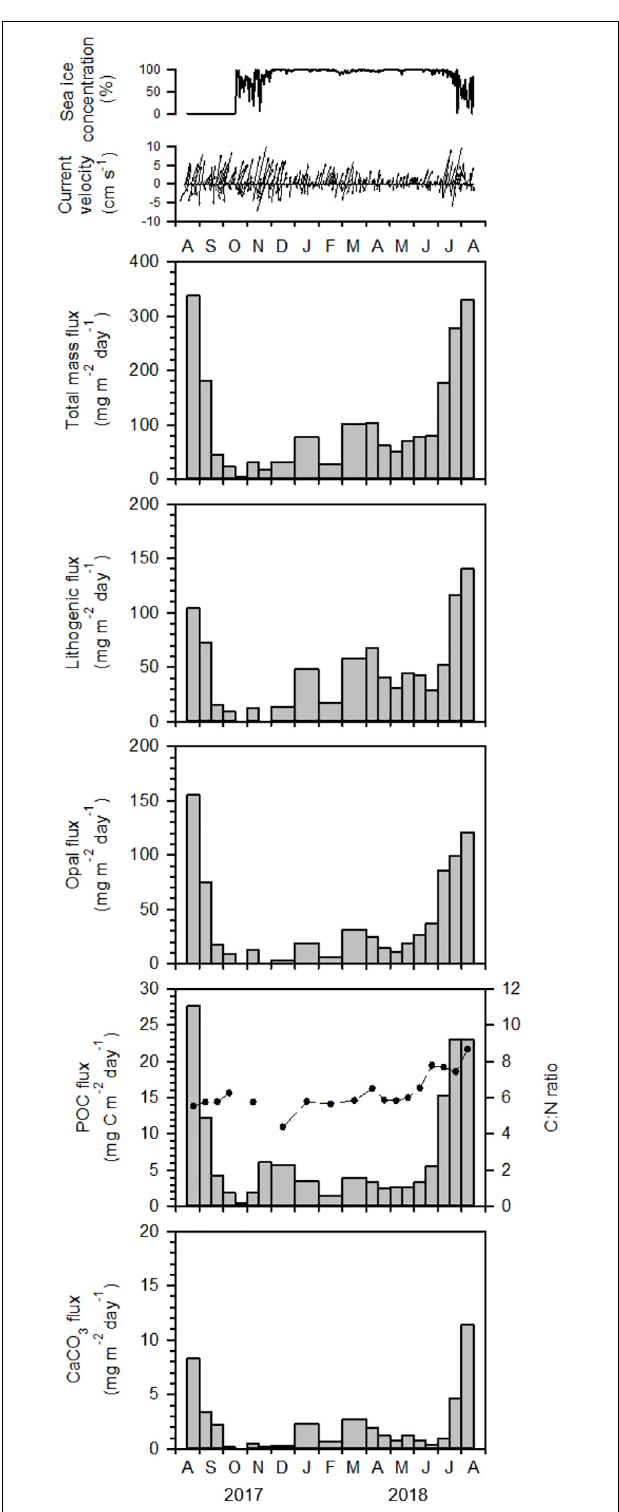
FIGURE 3 | Sea-ice concentration, current velocity, total mass flux, POC flux (vertical bar), C:N ratio (dashed line), biogenic opal flux, CaCO 3 flux, and lithogenic flux at 325 m water depth in the Chukchi Sea (KAMS 2) from August 2017 to August